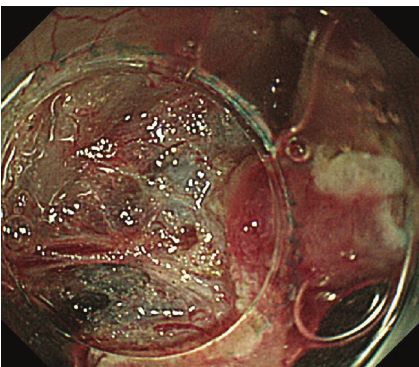
Figure 4: A view on the en-bloc resected specimen. The surgical margin is visible.